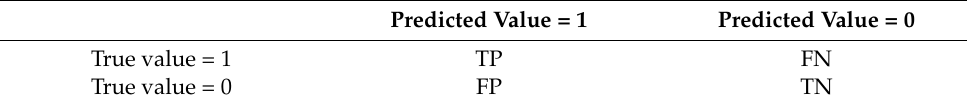
Table 1. Schedule of precision evaluation formulas.